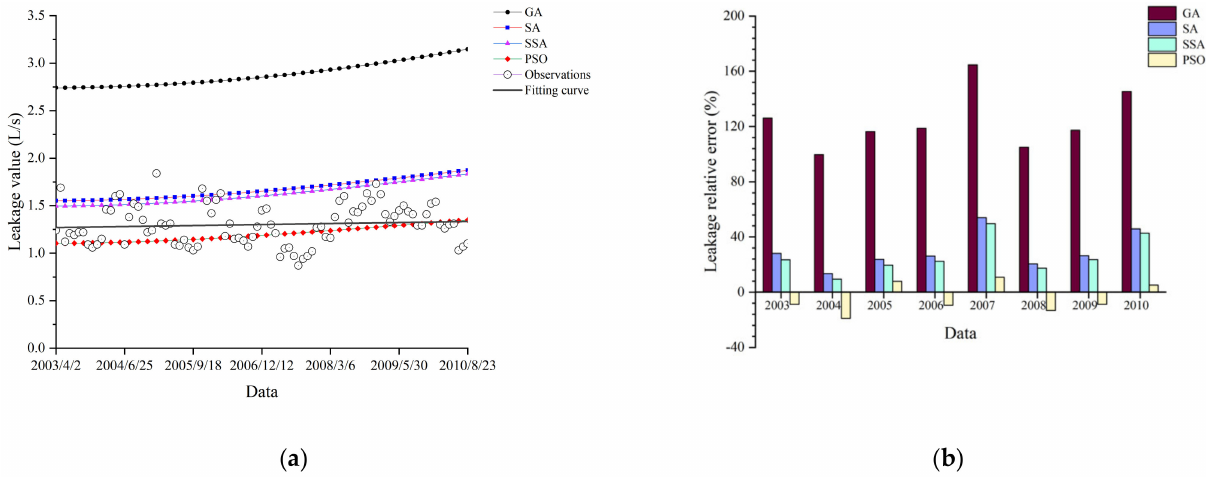
Figure 6. Comparison of measured and simulated values at the dam foundation: ( a ) leakage; ( b ) leakage relative